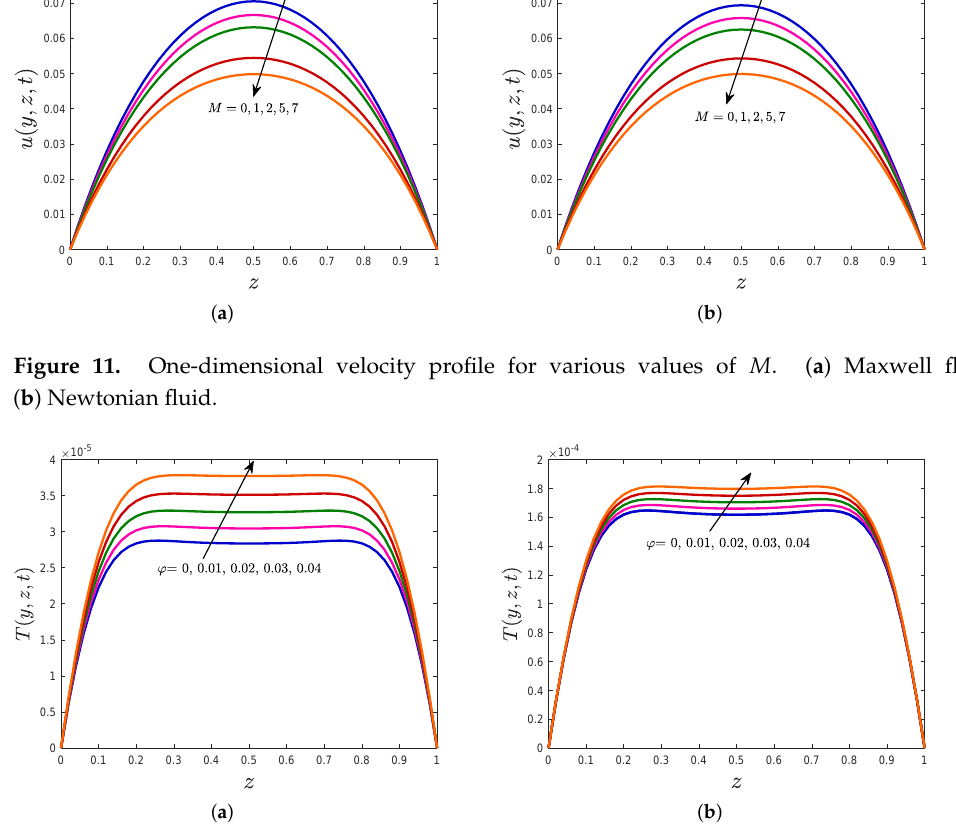
Figure 12. One-dimensional temperature profile for various values of ϕ . ( a ) Maxwell fluid, ( b ) Newtonian fluid.